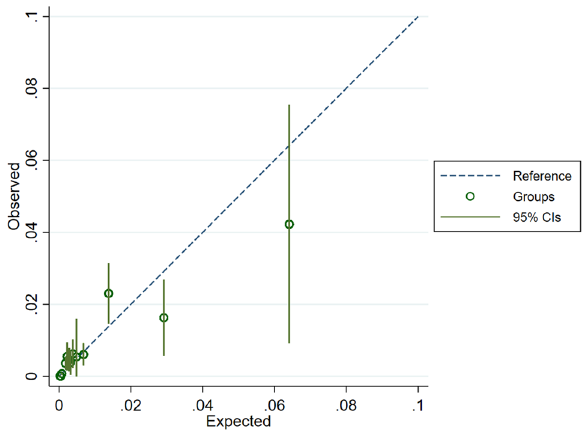
Figure 4. A calibration plot showed the agreement between the observed and predicted probability of IHCA. IHCA in-hospital cardiac arrest.